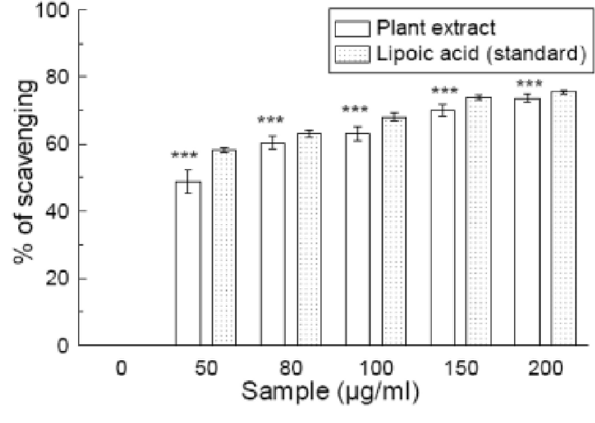
O scavenging assay Figure 5 H 2 2 H O scavenging assay . Effects of Spondias pinnata plant 2 2 extract and the standard sodium pyruvate on the scavenging of H O . The data represent the percentage H 2 2 ing. All data are expressed as mean ± S.D. (n = 6). ** p < 0.01 and *** p < 0.001 vs 0 mg/ml. IC IC value of the standard is 3.24 ± 0.3 mg/ml. 50